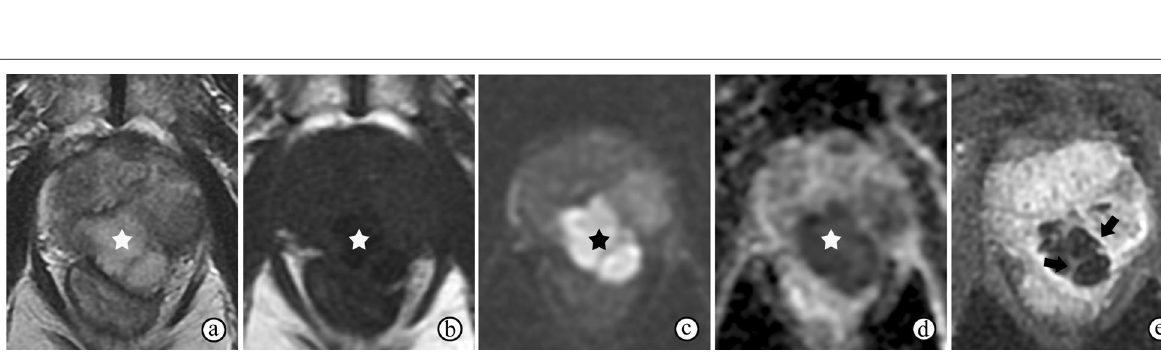
Fig. 5 Prostate abscess in a 68-year-old male with dysuria for 2 months and a serum PSA level of 9.50 ng/mL, 16.9 white blood cells/high power field in urine and 1.7 epithelial cells /high power field in urine. a, b T2- and T1-weighted imaging show a mass with high T2 signal intensity and low T1 signal intensity ( ☆ ) in the PZ compressing the rectum. c, d The interior of the mass shows a very high signal intensity on DWI at a b-value of 800 s/ mm 2 and a very low signal intensity on the ADC maps ( ☆ ). e DCE imaging shows enhancement of the rim and separations in the middle